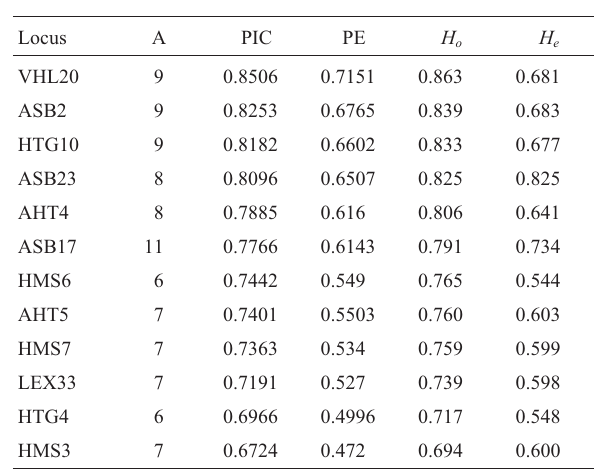
Table 2 - Number of alleles (A), polymorphic information content (PIC), exclusion probabilities (PE) and observed and expected heterozygosity ( H o and H e respectively) of microsatellite markers in a sample of Pan- taneiro